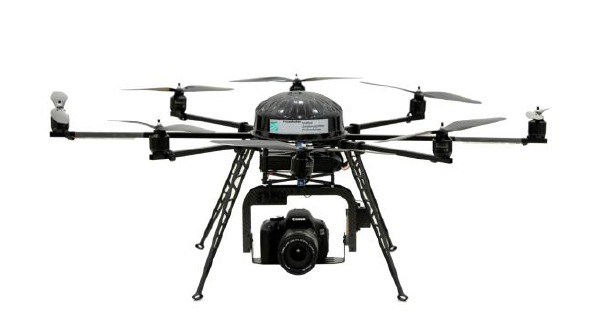
Figure 1. Octocopter UAS